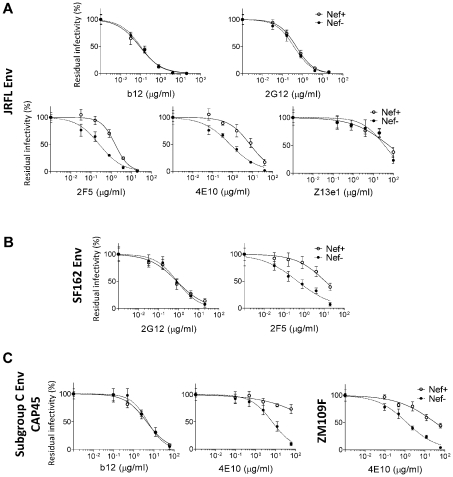
Virus particles pseudotyped with Env Glycoproteins derived from diverse HIV-1 isolates are responsive to the Nef effect on the susceptibility to 2F5 and 4E10.Neutralization of Nef-positive and Nef-defective HIV-1NL4-3 virus particles pseudotyped with Env glycoproteins derived from HIV-1JRFL (A), from HIV-1SF162 (B) and from two HIV-1 subgroup C isolates (C). Neutralization was performed three times independently. Shown are the mean values and SD.